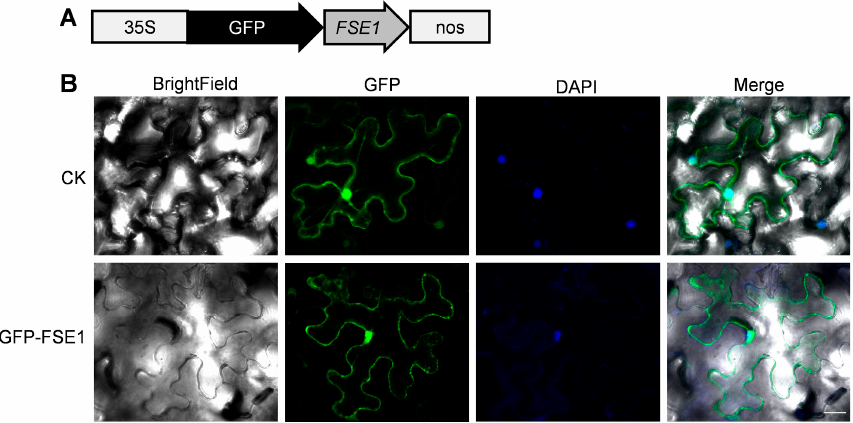
Figure 5. FSE1 is distributed in cytoplasm and nuclei of N. benthamiana epidermal cells. ( A ) Expression cassette of GFP-FSE1. ( B ) Fluorescence microscopes. CK, cells expressing empty GFP; DAPI, 4 ′ ,6-diamidino-2-phenylindole. Scale Bar = 25 μ m.